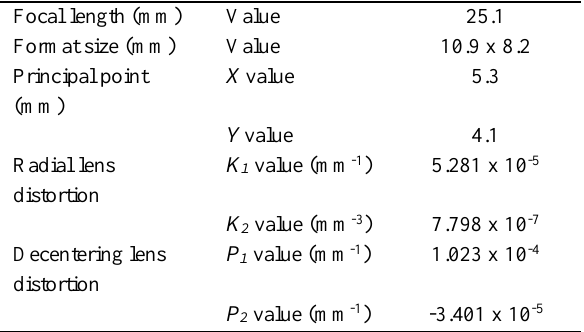
Table 3. Interior orientation parameters of thermographic camera FLIR SC655, result of its geometric calibration.